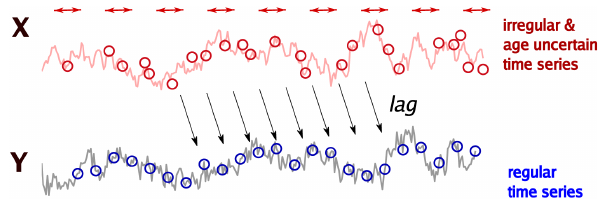
Fig. 1. Illustration: assume that the climatic process Y is driven by process X at a given lag. They are sampled by a paleoclimate proxy archive ( X ) and an automatized measurement device ( Y ), resulting in corresponding time series. A typical task in paleoclimate data analysis is to estimate the strength of statistical association between such time series; the delay time can hint at physical driving mecha-